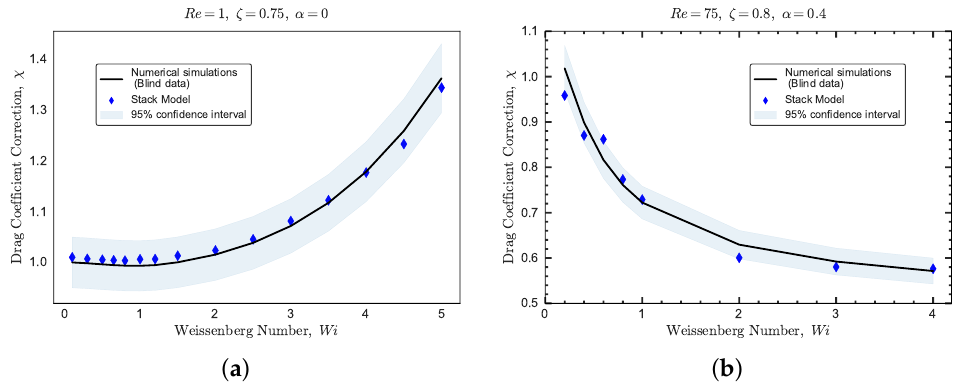
Figure 15. Performance of the meta-model (stack model) against the blind datasets generated for Oldroyd-B and Giesekus fluids. The blind datasets are shown using solid lines for the flow of an Oldroyd-B fluid past a sphere at ( a ) Re = 1, ζ = 0.75 and α = 0; and for the flow of a Giesekus fluid past a sphere at ( b ) Re = 75, ζ = 0.8 and α = 0.4. The predictions obtained with the meta-model are represented by diamond symbols. A 95% confidence interval region for the predictions is also